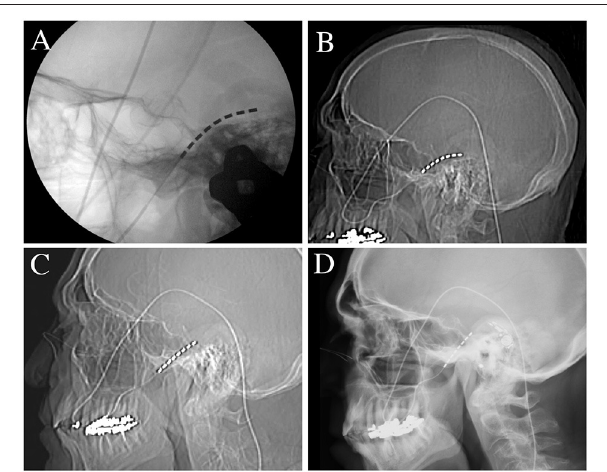
FIGURE 3 | Radiographs of permanent electrode placement, secured with the novel anchoring technique. (A) Intra-operative lateral skull radiograph showing placement of the lead within the foramen ovale. (B) Immediate postoperative lateral skull radiograph showing preserved lead position. (C) Lateral skull radiograph was taken 3-days after permanent electrode implantation showing mild descent of the electrode by 3 contacts ( ∼ 13mm). (D) Lateral skull radiograph performed at 6 months showing no further movement of the lead.